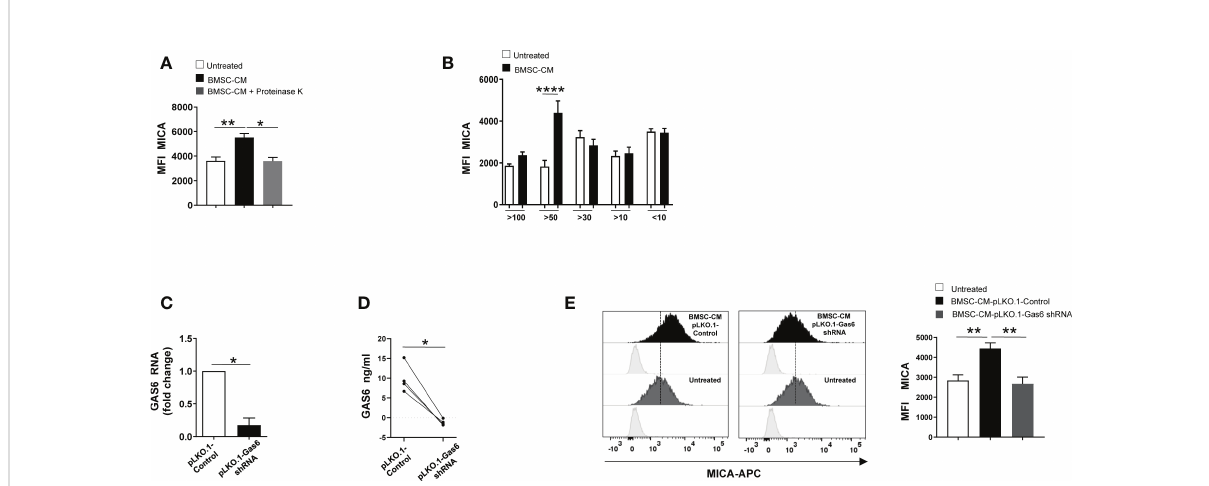
FIGURE 4 GAS6 controls MICA up-regulation in BMSC-CM-treated MM cells. Flow cytometry analysis of MICA surface expression on SKO-007(J3) cells cultured for 72h in BMSC-CM, pre-treated or not with proteinase K (A) , or in fractions of different molecular weight obtained from BMSC-CM (n=8) (B) . Histograms represent the MFI of speci fi c mAb subtracted of MFI of isotype control. Data show mean ± SD ( *p < 0.05; **p < 0.005; ****p < 0.001; ANOVA). Analysis of GAS6 mRNA (C) and protein (D) in BMSCs infected with lentiviral vector expressing GAS6 shRNA (pLKO.1- GAS6 shRNA) or scramble control (pLKO.1-Control) (n=4). Data show mean ± SD (*p < 0.05; Mann-Whitney Test). MICA surface expression was analyzed by FACS on SKO-007(J3) treated for 72h with CM derived from BMSCs pLKO.1-GAS6 shRNA or pLKO.1-Control (n=3) (E) . Histograms represent the MFI of speci fi c mAb subtracted of MFI of isotype control. Data show mean ± SEM ( **p < 0.001;